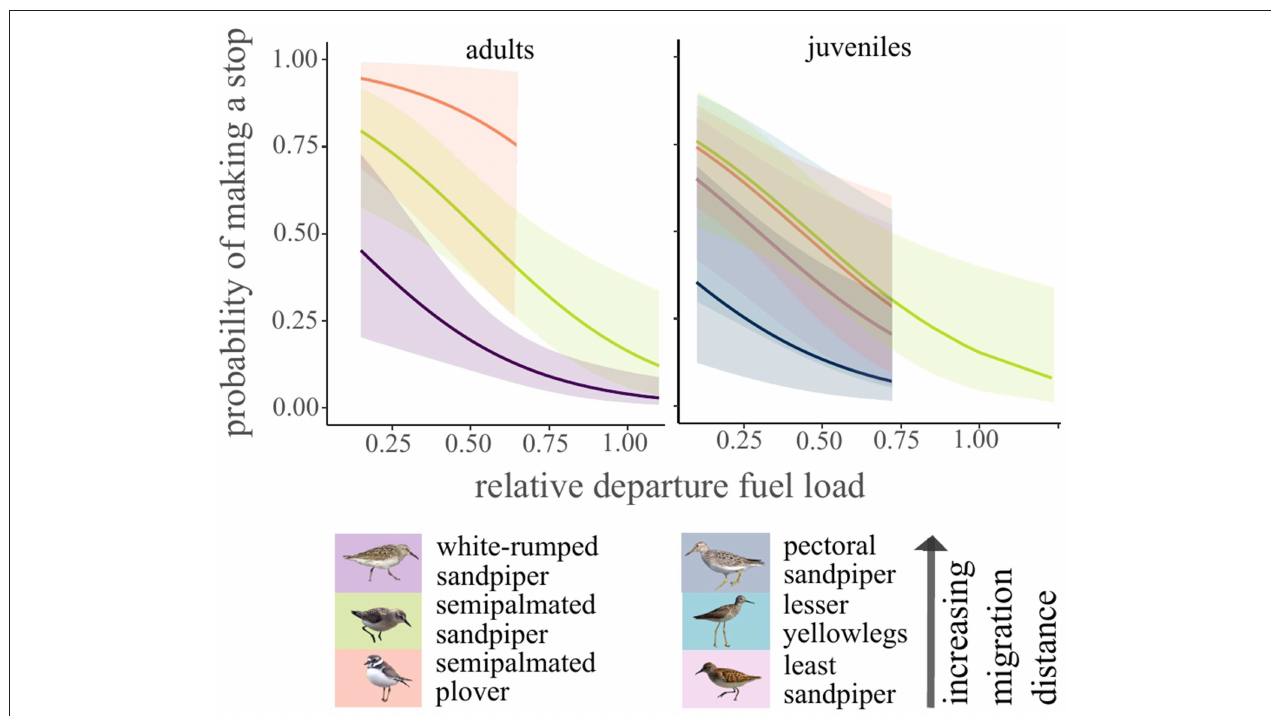
FIGURE 6 | Model predicted stopover probability for shorebirds in North America after departing James Bay, Ontario, Canada in years 2014–2017. Species was not a significant predictor for juveniles ( α = 0.05) but is plotted here to show the pattern. Least sandpipers had the same predicted pattern as lesser yellowlegs.